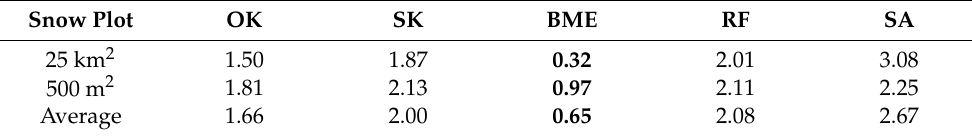
Table 2. MAE of five upscaling results for two ground observation scales (unit: cm). Snow Plot OK SK BME Snow Plot